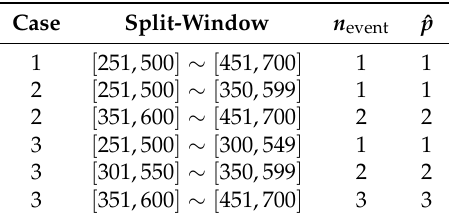
Table 5. Relationship between the number of constituent components in a multiple event ( n event ) and the number of factors ( ˆ p